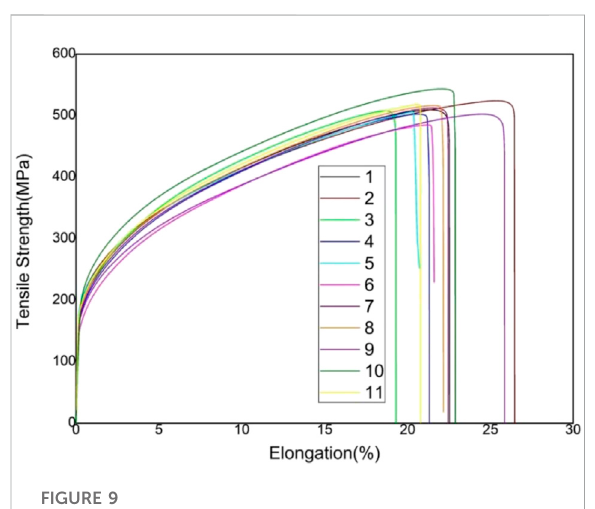
FIGURE 9 Engineering stress – strain curves of the tensile